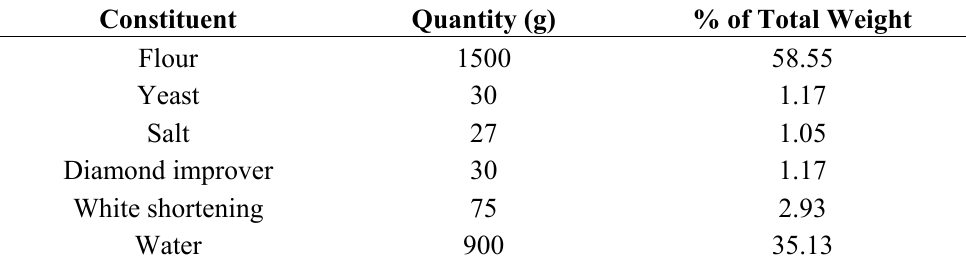
Table 1. Formulation of